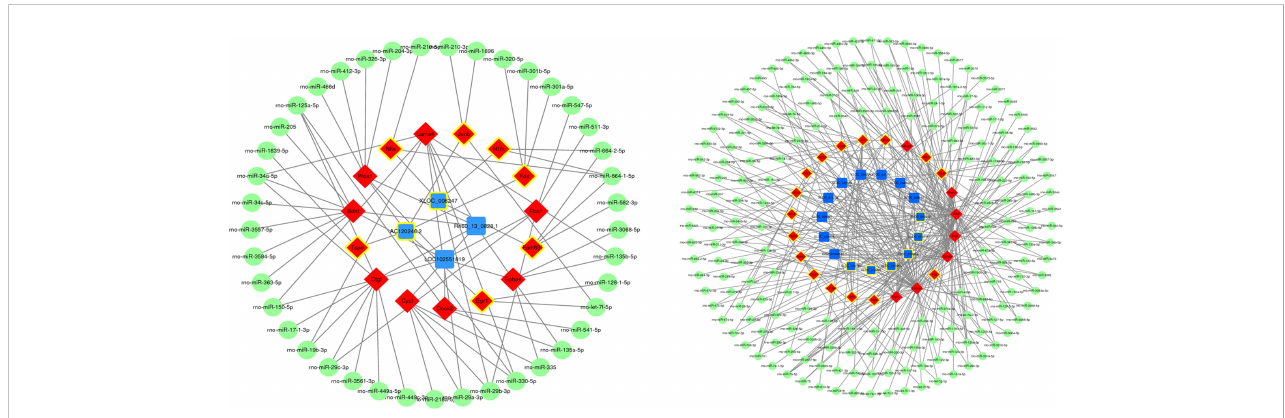
FIGURE 5 Construction of competitive endogenous RNA networks. Nodes with yellow circles indicate upregulated RNA, while nodes without yellow circles indicate downregulated RNA. lncRNA, mRNA, and miRNA are shown in blue, red, and green